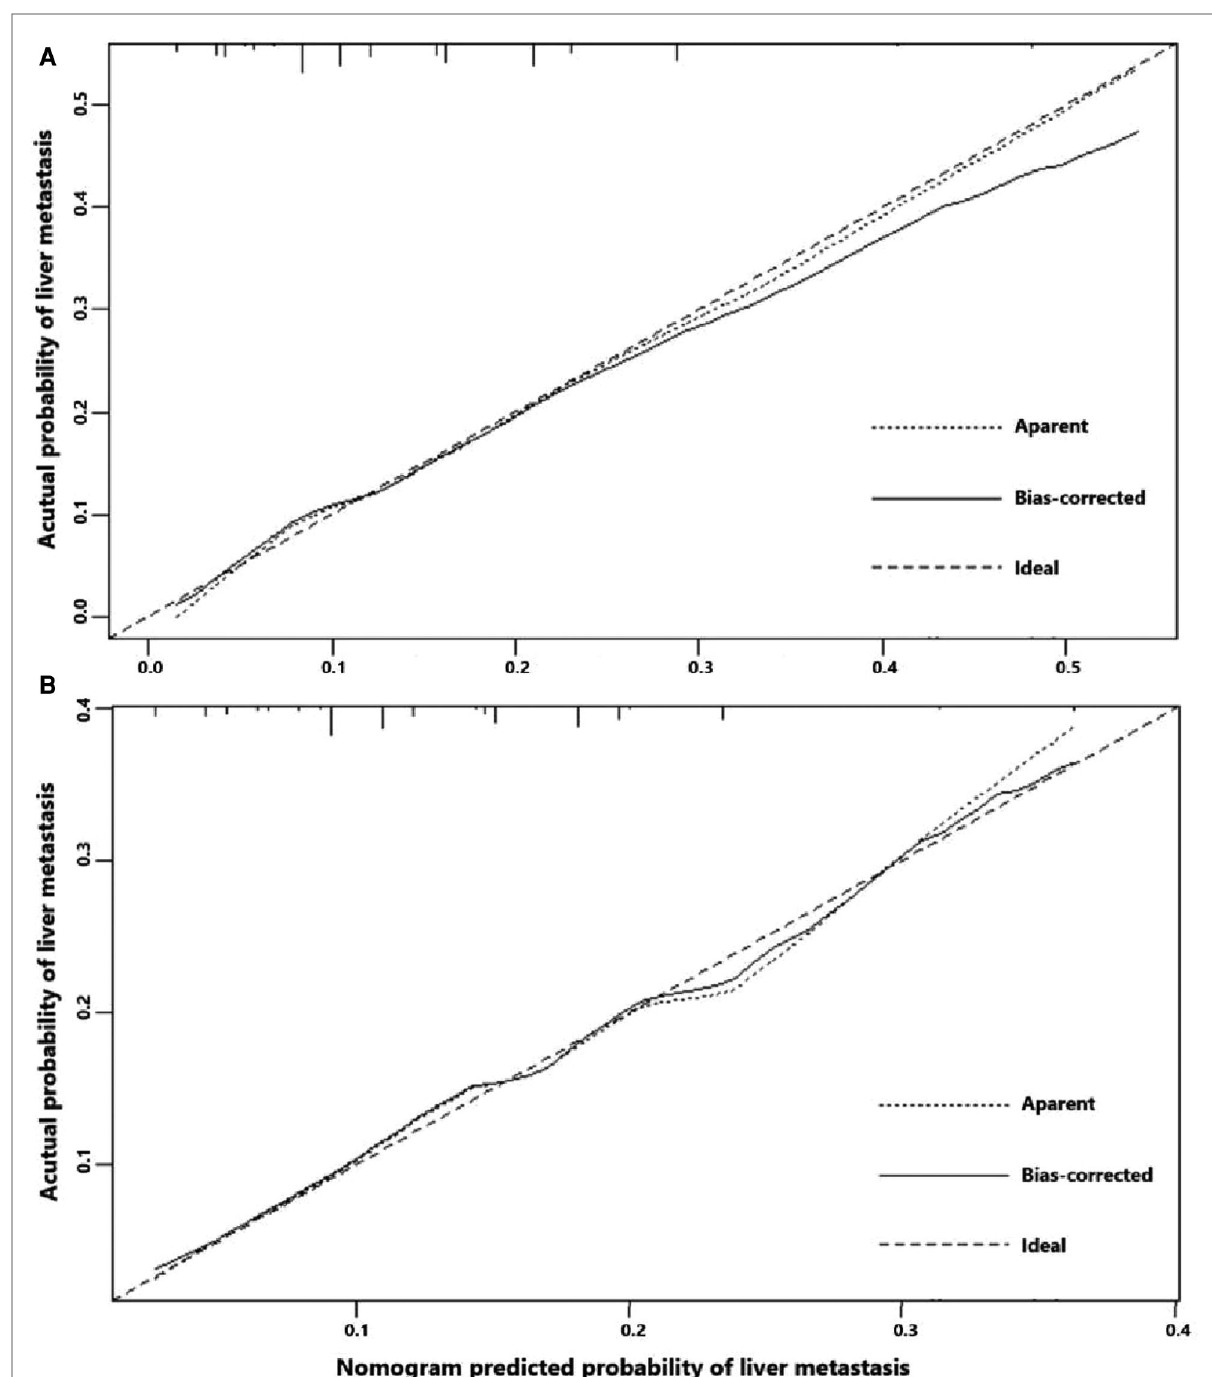
FIGURE 4 ( A ) Calibration curve of the constructed nomogram for predicting liver metastasis in the training cohort. ( B ) Calibration curve of the constructed nomogram for predicting liver metastasis in the testing